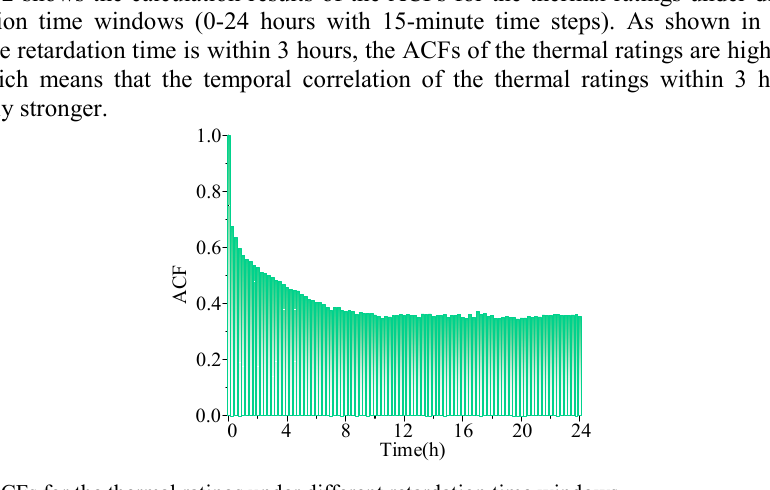
Fig. 2. ACFs for the thermal ratings under different retardation time